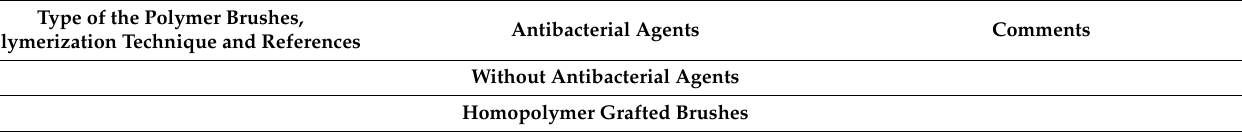
Table 3. Summarized information about antibacterial